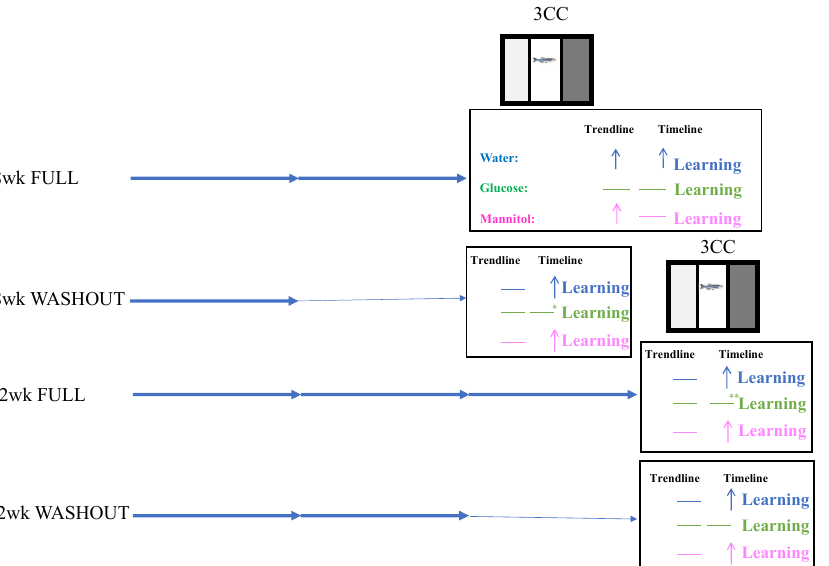
Figure 11. Overview of cognitive and visual performance. For each experiment: 8 wk Full = 8 weeks of hyperglycemia; 8 wk WO = 8-week washout experiment with fish exposed to glucose for 4-weeks followed by a 4-week recovery period; 12 wk Full = 12 weeks of hyperglycemia; 12 wk WO = 12-week washout experiment with fish exposed to glucose for 8-weeks followed by a 4-week recover period. Here we can see that water-treated fish displayed learning in over 50% of the analyses (denoted by the arrow), whereas mannitol displayed learning in exactly 50% of the analyses. Glucose-treated fish displayed learning in 0% of the analyses with two exceptions. At 8 wk washout denoted by the single asterisk, glucose-treated fish showed evidence of slight learning although they did not pass the threshold, and at 12-weeks full denoted by the double asterisk glucose-treated fish showed evidence of memory, but no new learning.